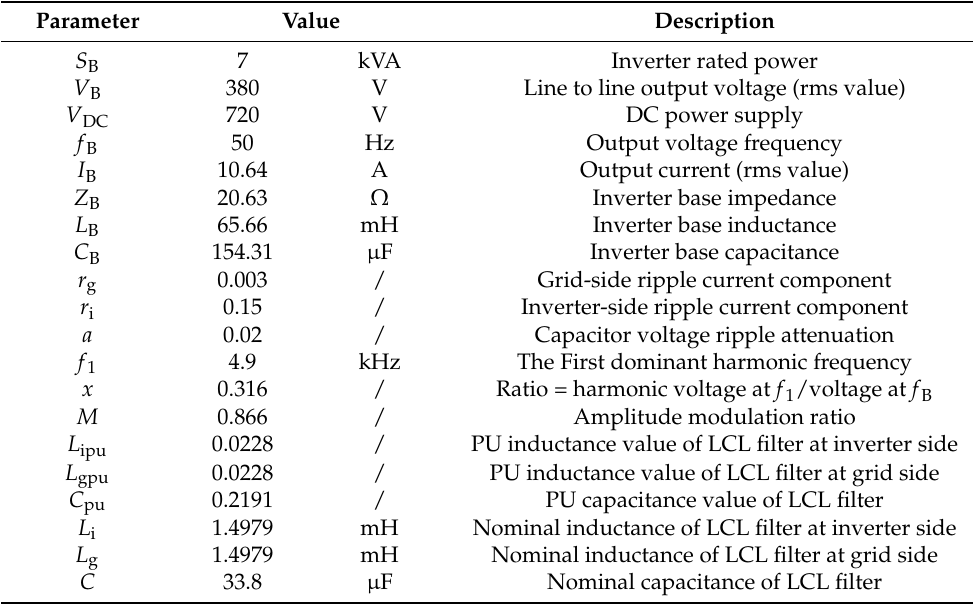
Table A2. Design parameters of LCL filter